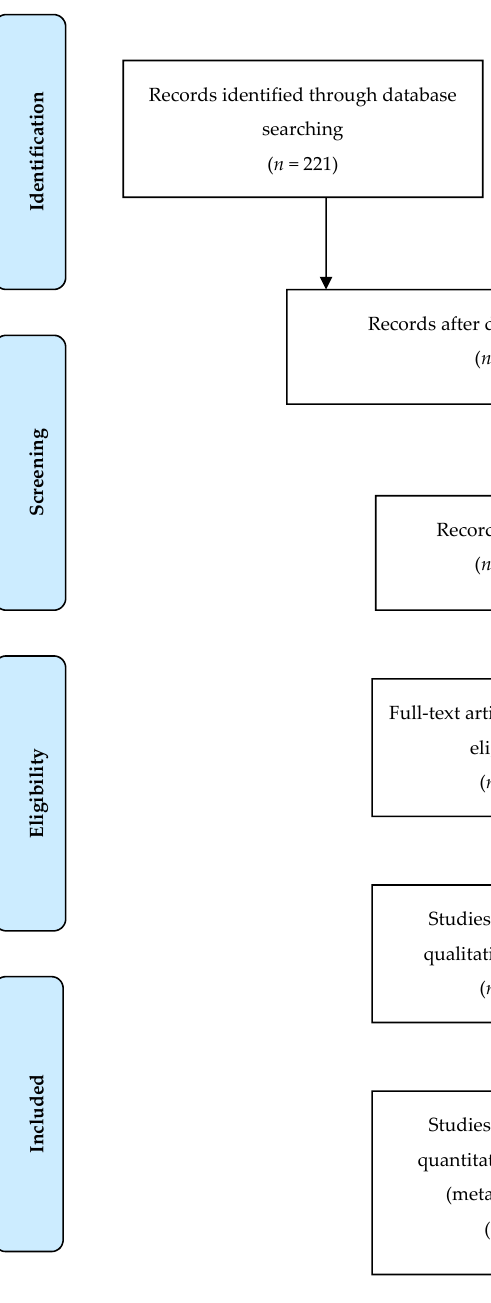
Figure 1. Flow chart of study selection.